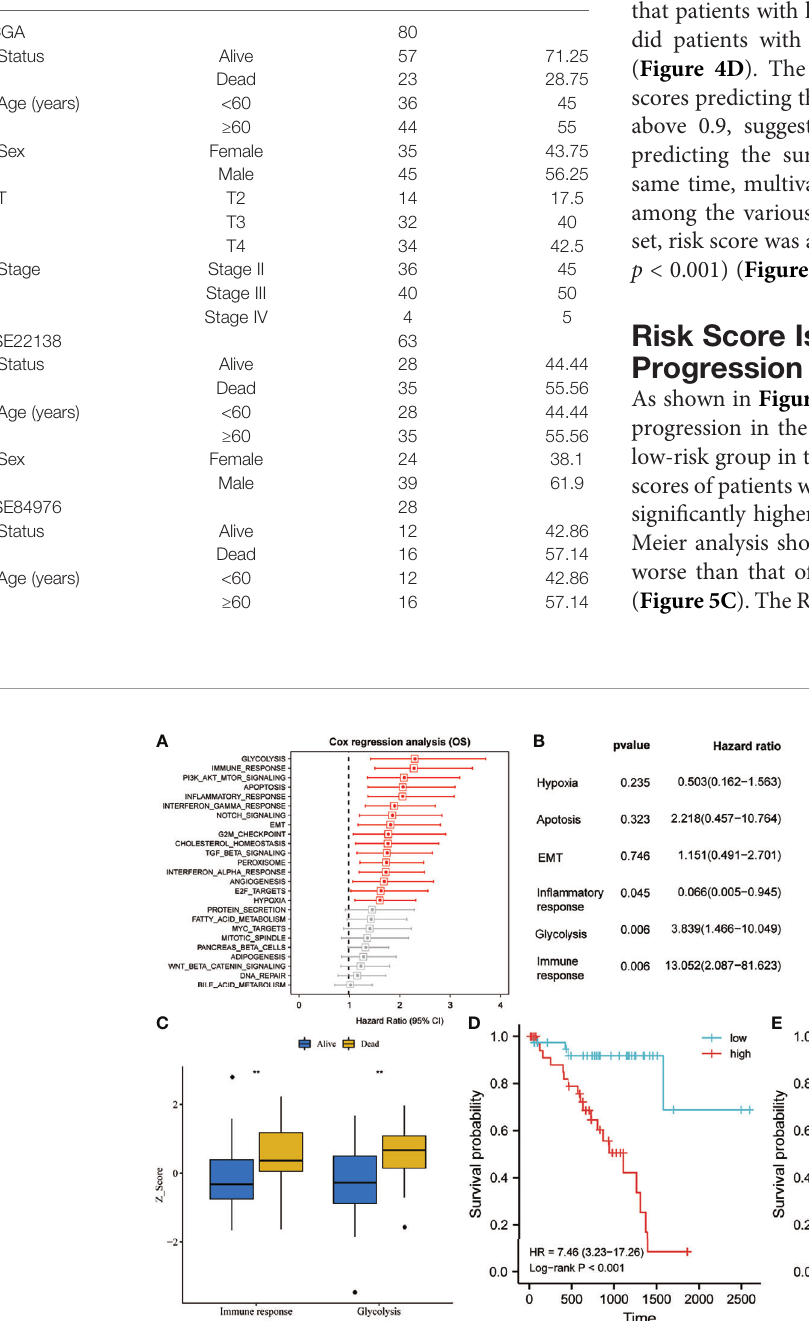
TABLE 1 | Baseline demographic and clinical information in The Cancer Genome Atlas (TCGA) and the Gene Expression Omnibus (GEO) cohorts. Clinical characteristics